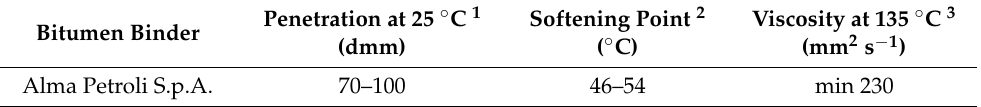
Table 1. Properties of bitumen 70/100